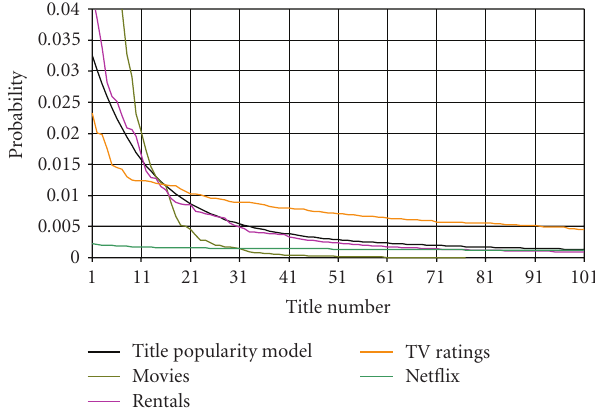
Figure 3: Video demand statistics and model. Statistics and probabilities are normalized so that the probability density of title #1 =